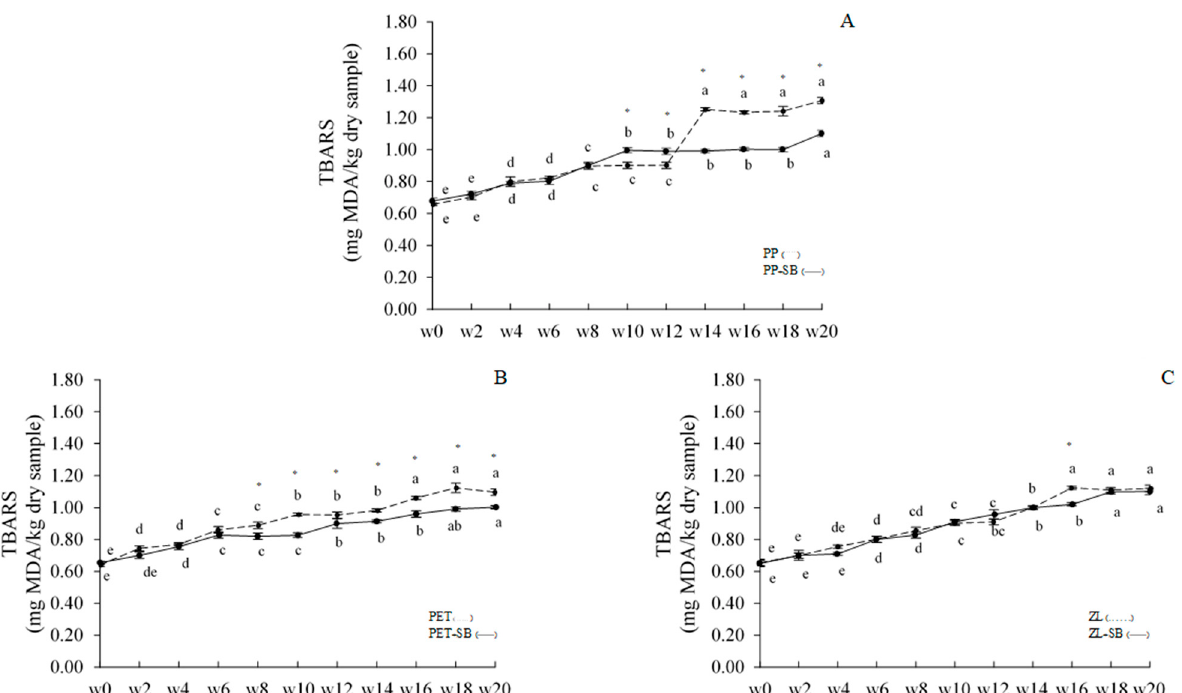
Figure 2 . Change in peroxide value ( PV ) of dried chili fish paste during storage in various packaging at room temperature ( 25 °C ). ( A ): PP ( . . . . . . )/ PP + SB : ( ____ ) , ( B ): PET ( . . . . . . )/ PET + SB : ( ____ ) , and ( C ): ZL ( . . . . . . )/ ZL + SB : ( ____ ). Significant differences between with / without added 0 . 1 % SB in samples stored in the same packaging material are indicated by an asterisk ((cid:28)) ( p < 0 . 05 ). Different lowercase letters in the same column denote significant differences ( p < 0 . 05 ) due to storage time .